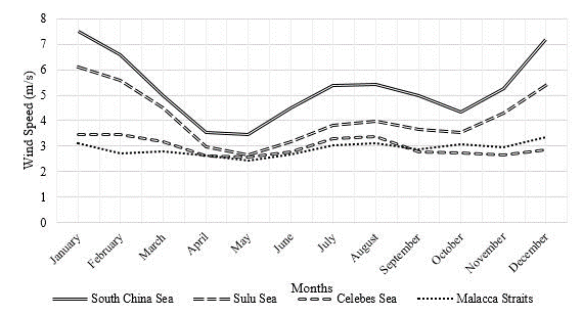
Figure 13. Monthly climatology of wind speed for each Malaysian seas over 24